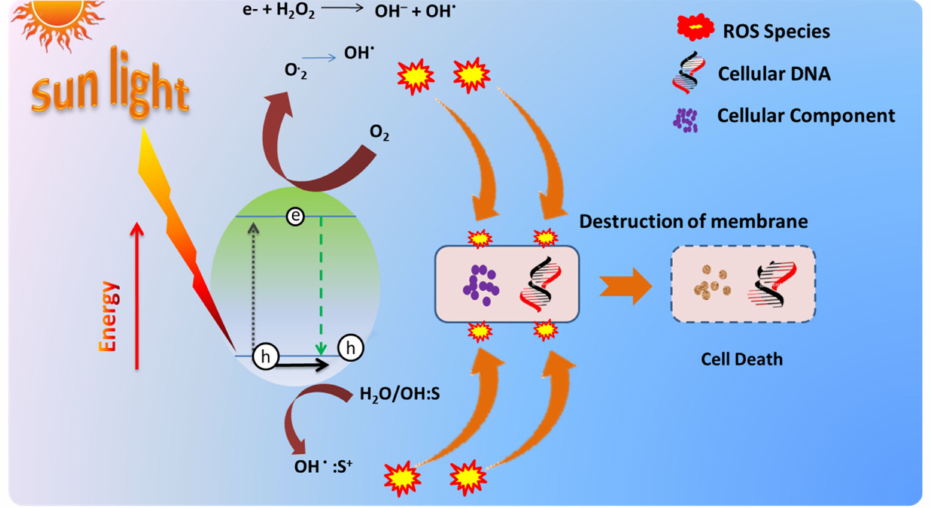
Figure 4. The fundamental mechanism of photocatalysis on a semiconductor particle surface for microbial